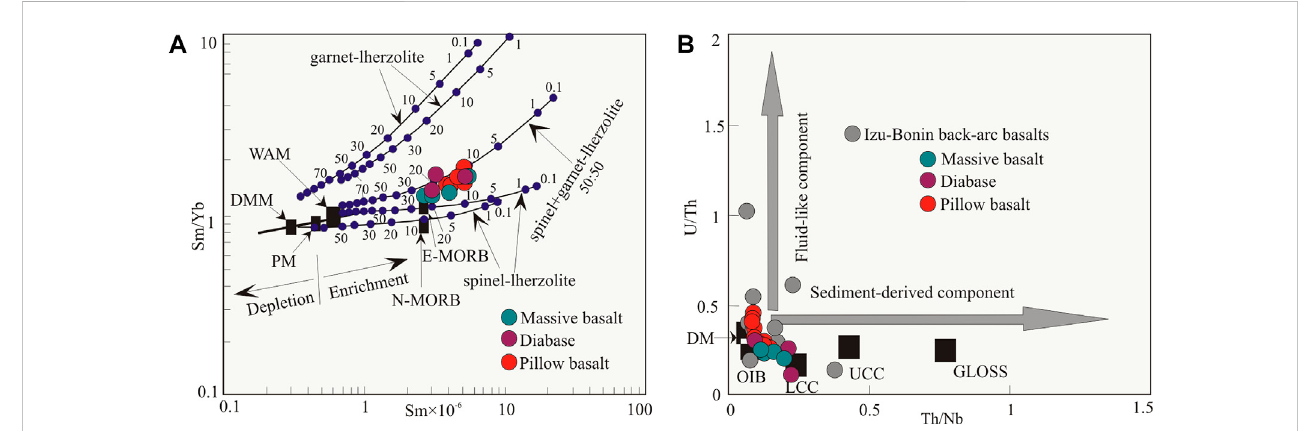
FIGURE 9 (A) Sm/Yb-Sm diagram (Aldanmaz et al., 2000) and (B) U/Th-Th/Nb diagram (Xie et al., 2016) of the basic igneous rocks in the Bairin Right Banner area, Inner Mongolia. Abbreviations: N-MORB, normal mid-ocean ridge basalt; E-MORB, enriched mid-ocean ridge basalt; DMM and DM, depleted mantle; WAM, western Anatolia mantle; UCC, upper continental crust; LCC, lower continental crust; PM, primitive mantle; GLOSS, global subducting sediment.